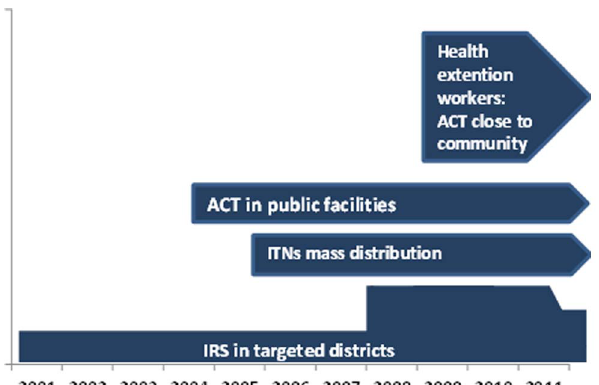
Figure 2. Timeline of implementation of antimalarial interven- tions, 2001–2011,